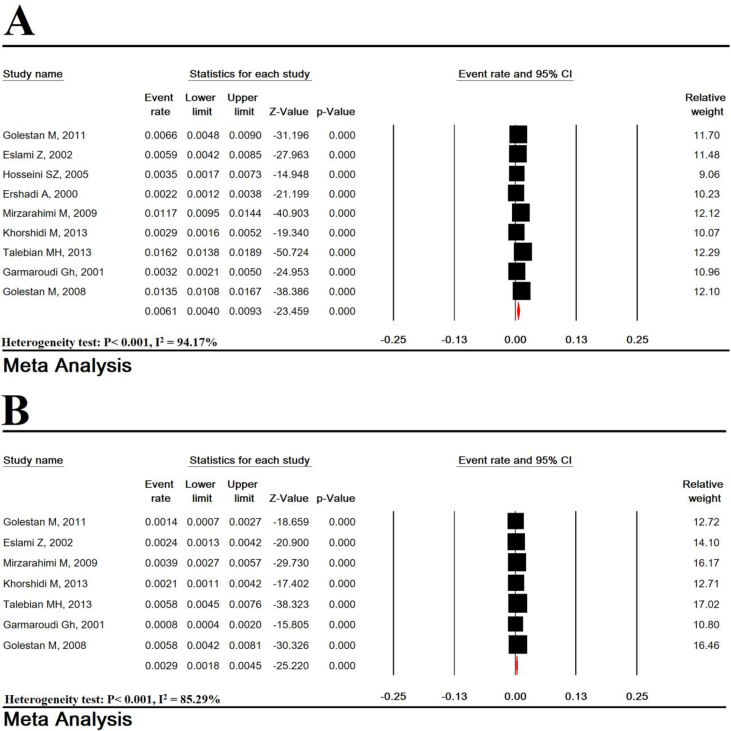
Prevalence of very low birth weight (A), and extremely low birth weight (B).